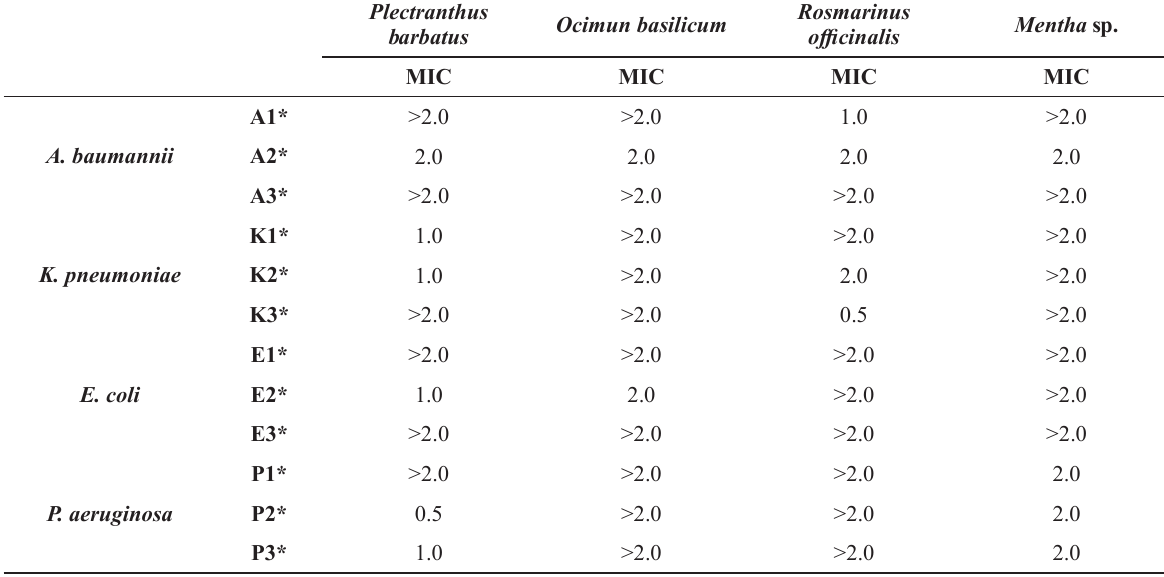
Minimal inhibitory concentration (MIC) from crude extracts of Lamiaceae family against Acinetobacter baumannii , Klebsiella pneumoniae , Escherichia coli and Pseudomonas aeruginosa multidrug-resistant bacteria strains. Plectranthus